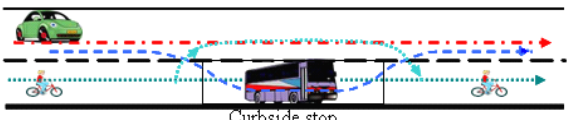
Fig. 1. Mixed traffic streams among buses, cars and bicycles near a curbside